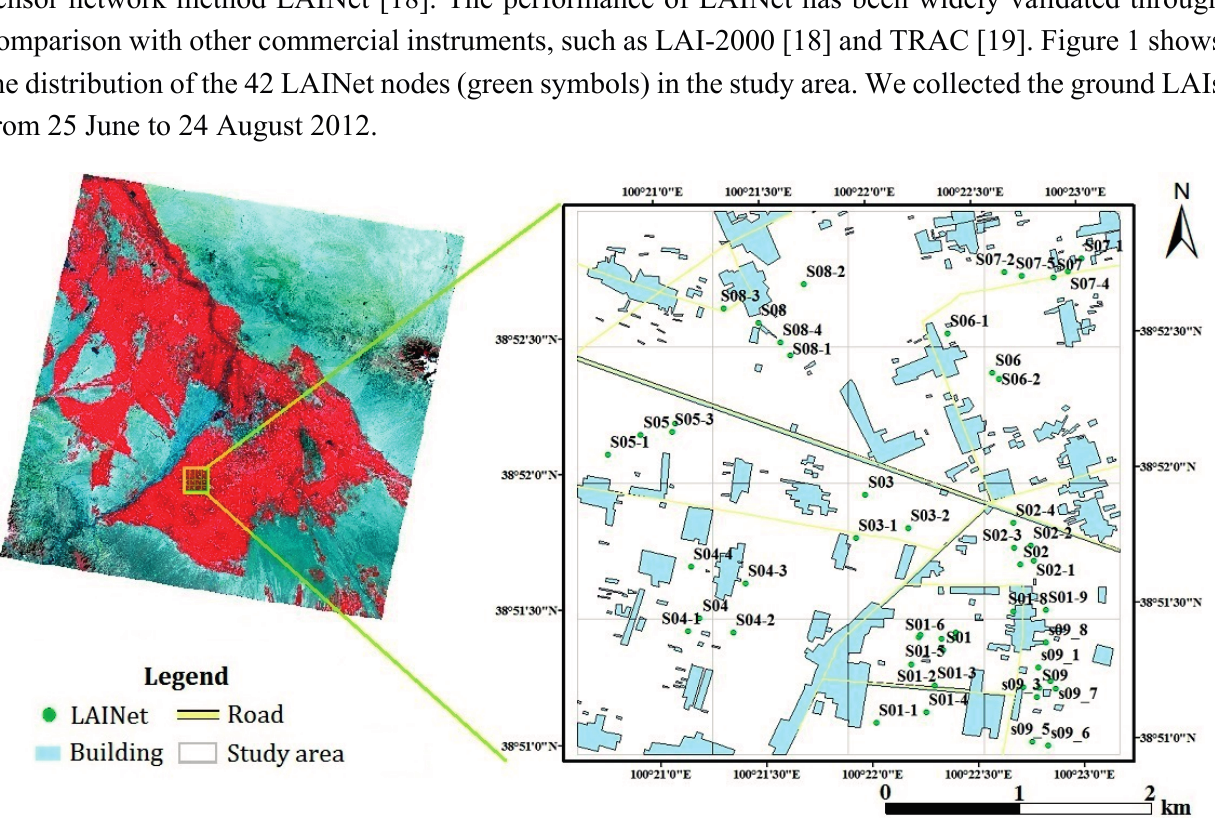
Figure 1. Distribution of the instruments in the study area. The green symbols are the location of the LAINet